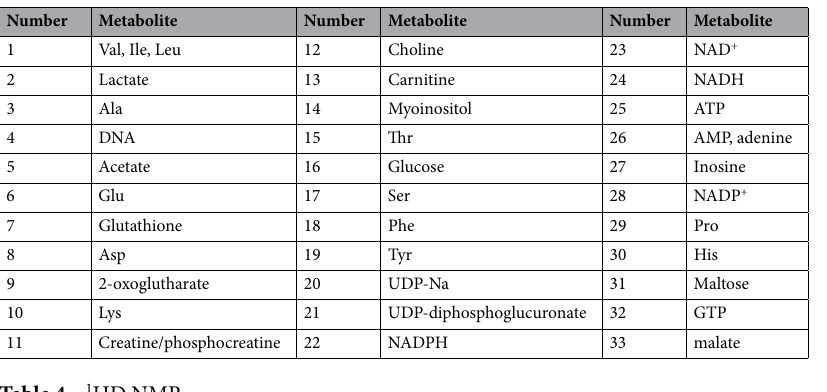
Table 4. 1 HD NMR.